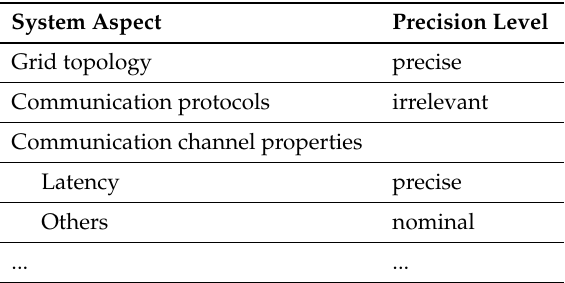
Table 2. Part of an exemplary assessment